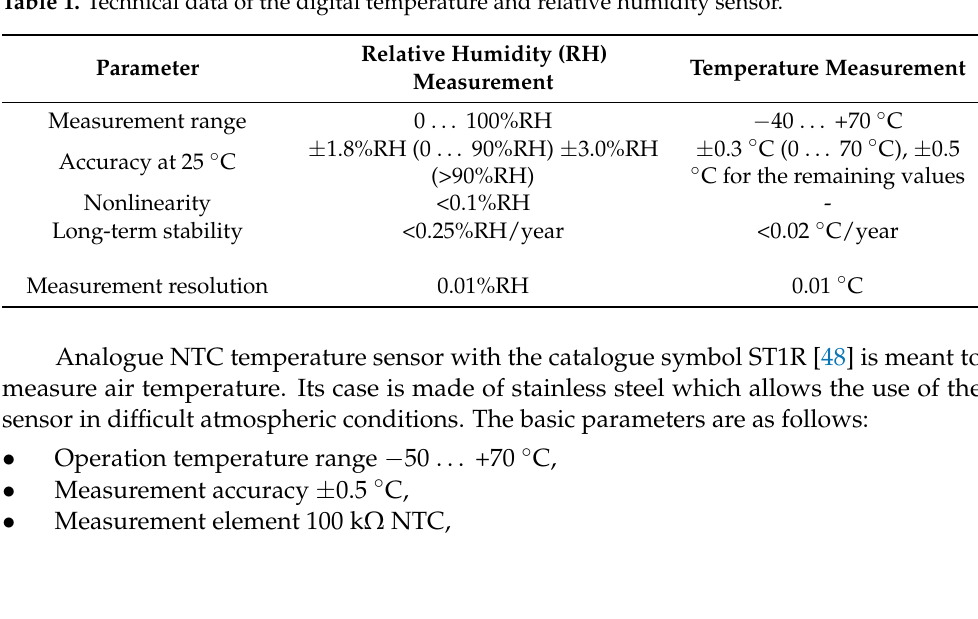
Table 1. Technical data of the digital temperature and relative humidity